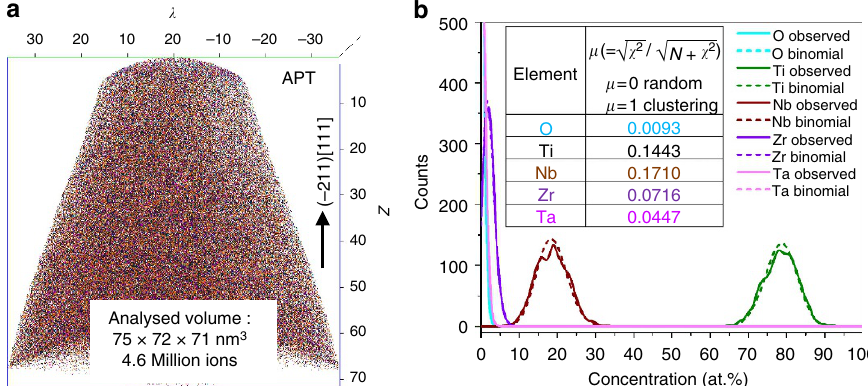
Figure 5 | APT analysis. ( a ) APT elemental map displays the atomic-scale local composition. ( b ) Frequency distribution curves for Ti, Nb, Ta, Zr and O atoms obtained from the APTdata shown in a ; binomial distributions for average solute contents are also shown for comparison, which stands for the ideal distribution in a homogenized